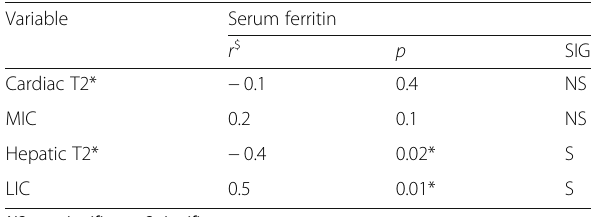
Table 6 Association between MIC and cardiac T2* in the studied group